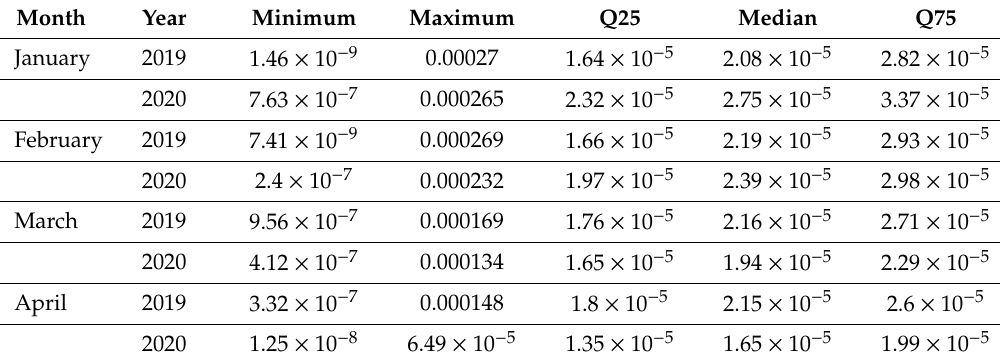
Table 2. Descriptive statistics of NO 2 concentration by month and year.